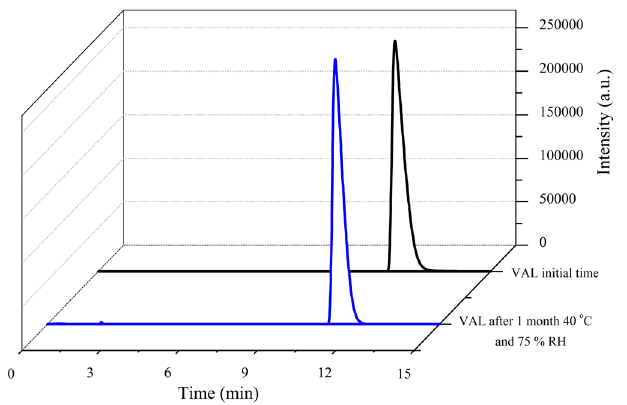
FIGURE 4 - HPLC chromatogram of VAL before and after 1 month at 40 ºC and 75%